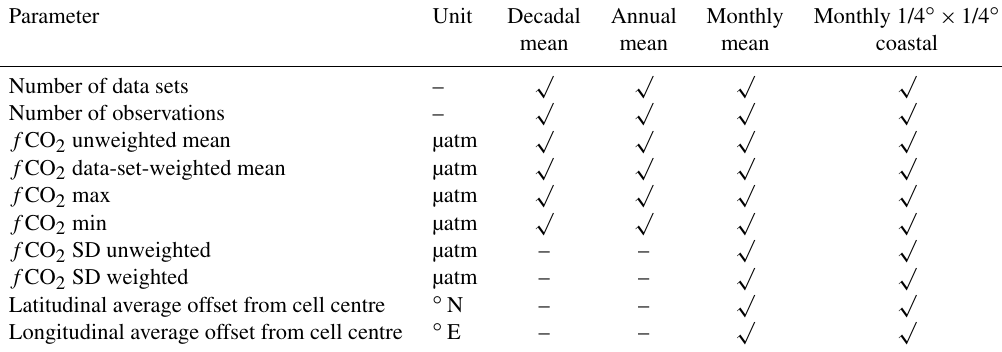
Table 10. Gridded products and parameters reported for each grid cell in SOCAT version 3 (after Sabine et al., 2013). Version 3 does not have a monthly climatology. Parameter Number of data sets Number of